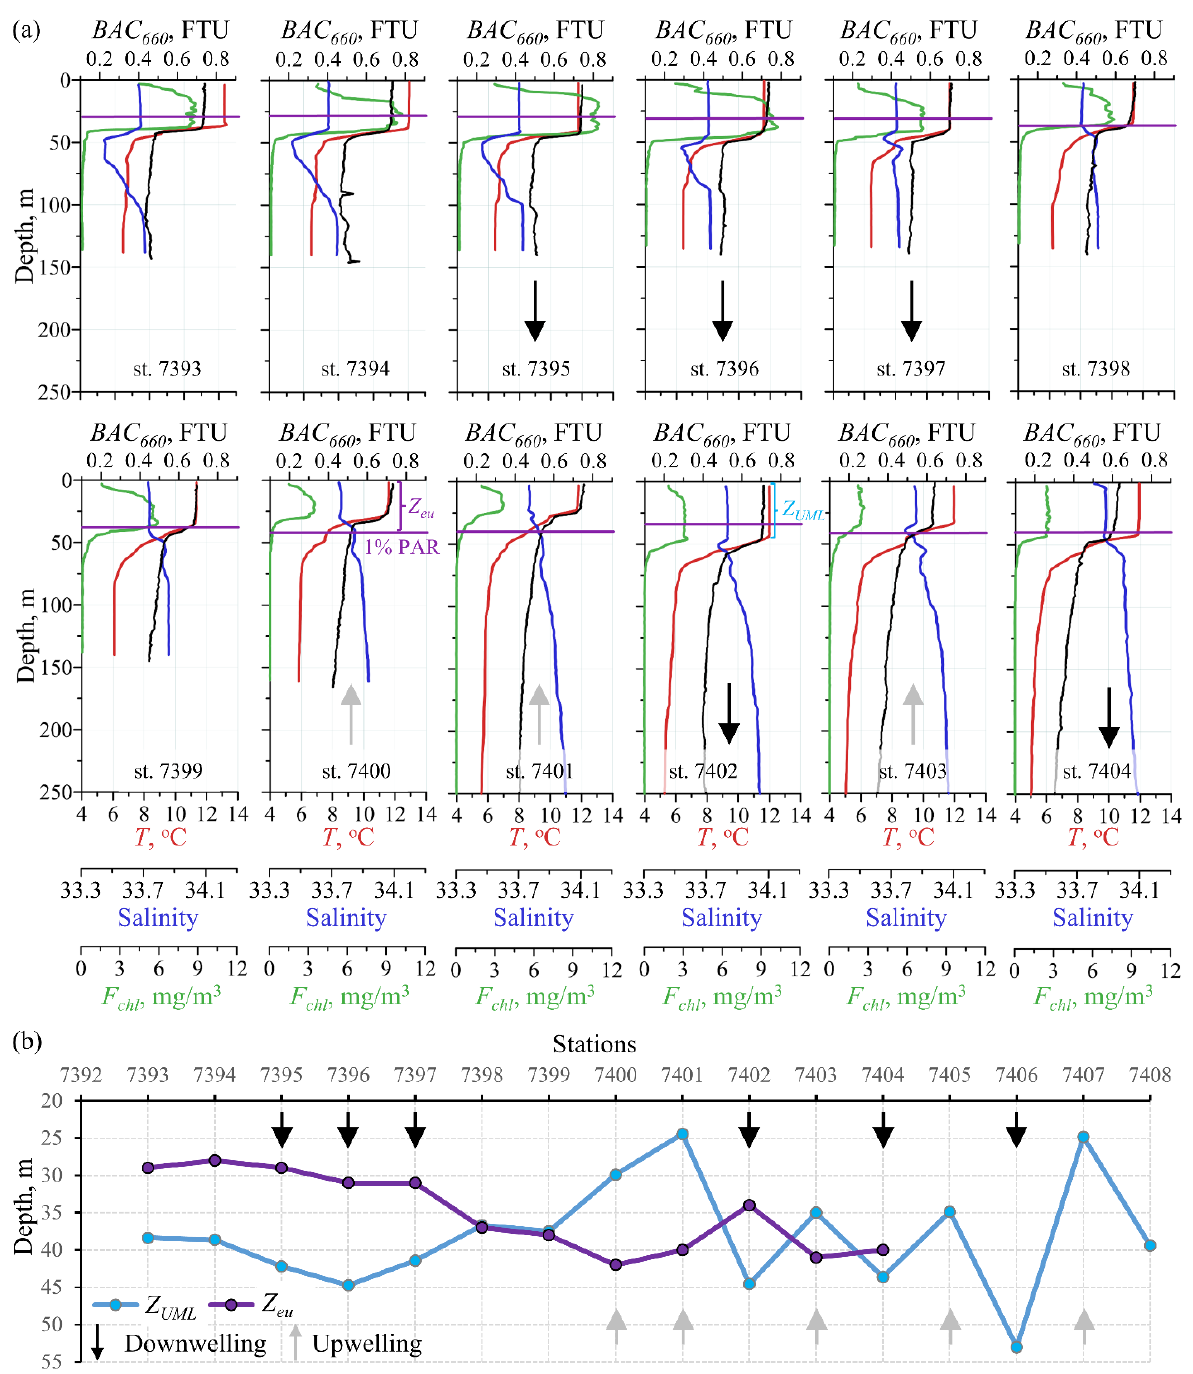
Figure 7. Vertical profiles of chl -a fluorescence (green), euphotic depth (purple), beam attenuation coefficient at 660 nm (black), temperature (red), and salinity (blue) at stations taken during daylight hours days ( a ). Variations in the euphotic depth ( Z eu ) and UML depth ( Z UML ) ( b ). Examples of Z eu and Z UML determination are presented for stations 7400 and 7402, respectively.